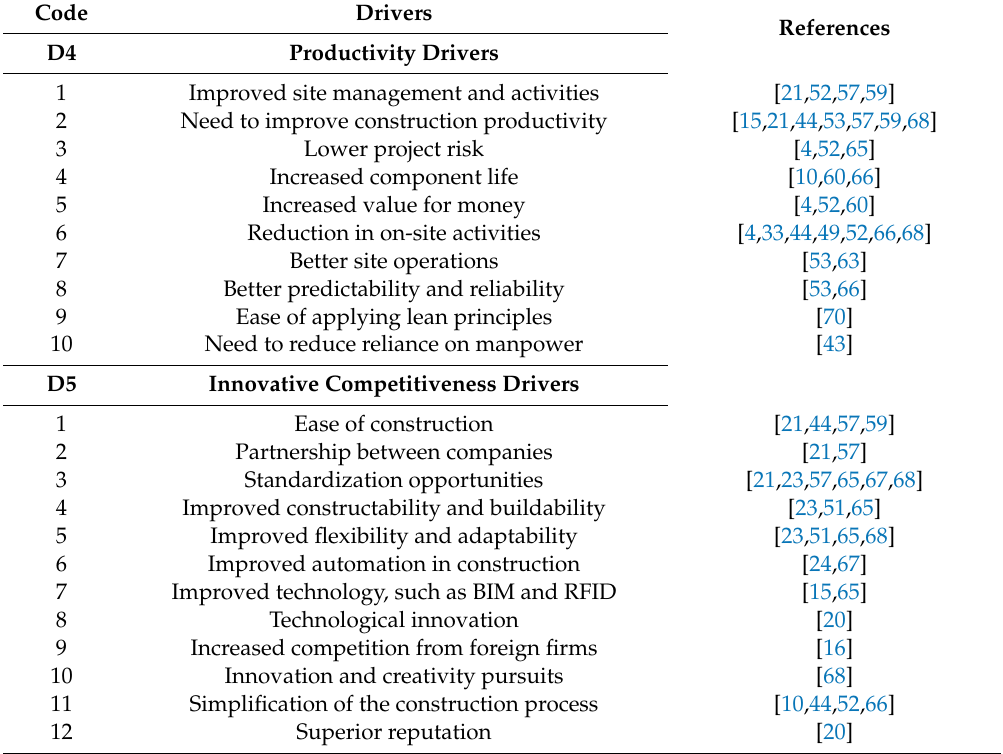
Table 2. Productivity, innovative competitiveness, and sustainability drivers of OSC.